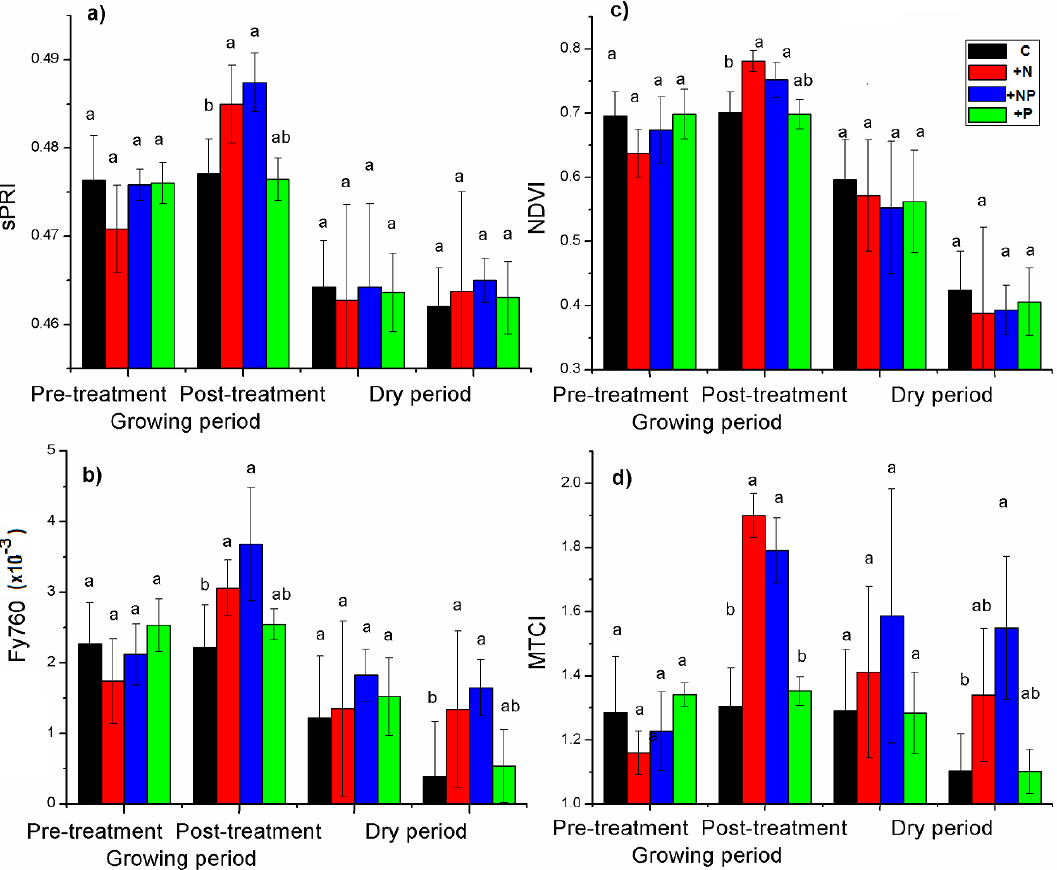
Figure 3. Seasonal time course of mean midday physiologically driven vegetation indices; (a) scaled photochemical reflectance index, sPRI (b) apparent fluorescence yield (Fy760), and structure-driven vegetation indices, (c) NDVI, and (d) MTCI among C, + N, + NP and + P treatments in a Mediterranean grassland in Spain. Bars indicate standard deviation, N = 4. Different letters denote significant differences between treatments (Weilch t test, p < 0 .